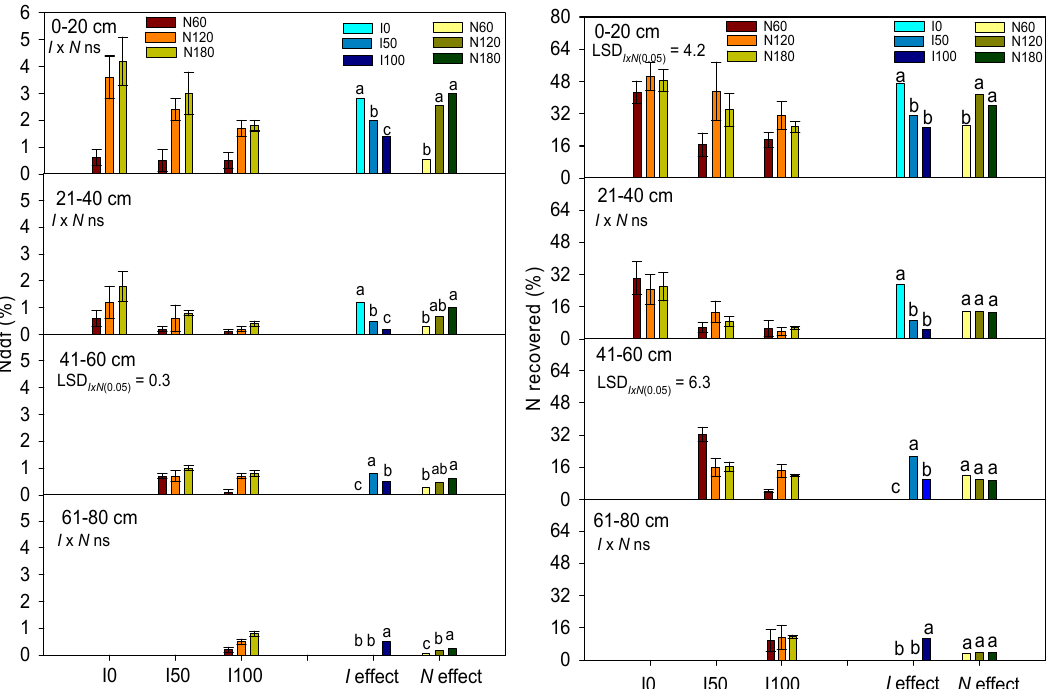
Figure 4. Soil N from the fertilizer ( Ndff , %) at different soil depths in relation to total soil N, and soil N from the fertilizer compared to total N applied by fertilization ( N recovered , %), in N fertilised treatments (N60, N120, N180 = 60, 120, 180 kg ha − 1 N) in sweet sorghum cv. Keller, under no irrigation (I0), deficit (I50) and full (I10) irrigation. Different letters within the main effects (I = irrigation; N = N level) indicate significant differences at p ≤ 0.05. Black vertical bars indicate the standard error. Table 3. Soil N from the fertilizer (kg ha − 1 ) at different depths in N fertilised treatments (N60, N120, N180 = 60, 120, 180 kg ha − 1 N, respectively) under no irrigation (I0), deficit (I50), and full (I100) irrigation. Values of the standard error are